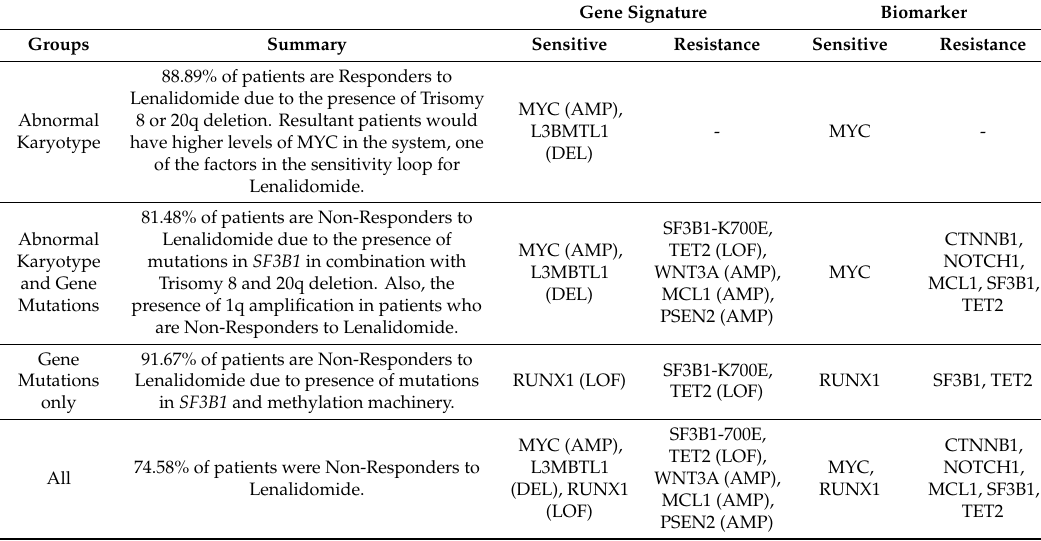
Table 1. Summary of Gene Signatures and Biomarkers Associating with Lenalidomide Sensitivity or Resistance.